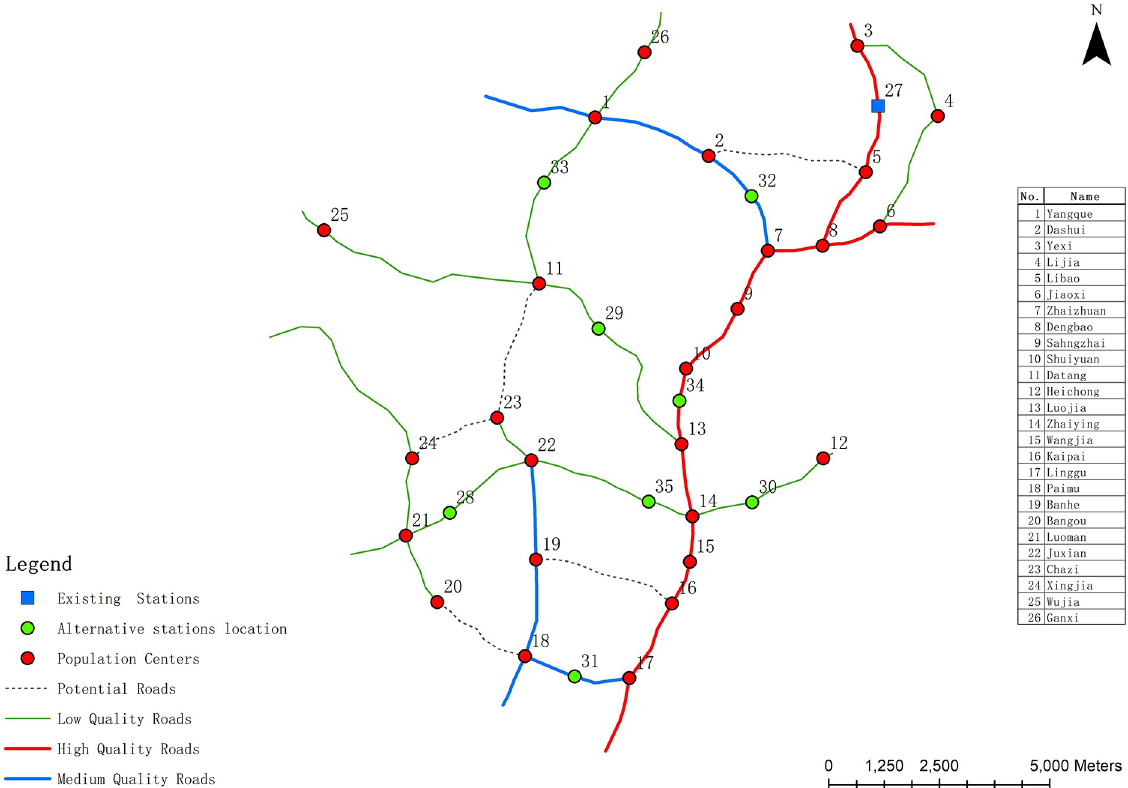
Fig 3. Road network with potential roads in the layout of the waste transfer